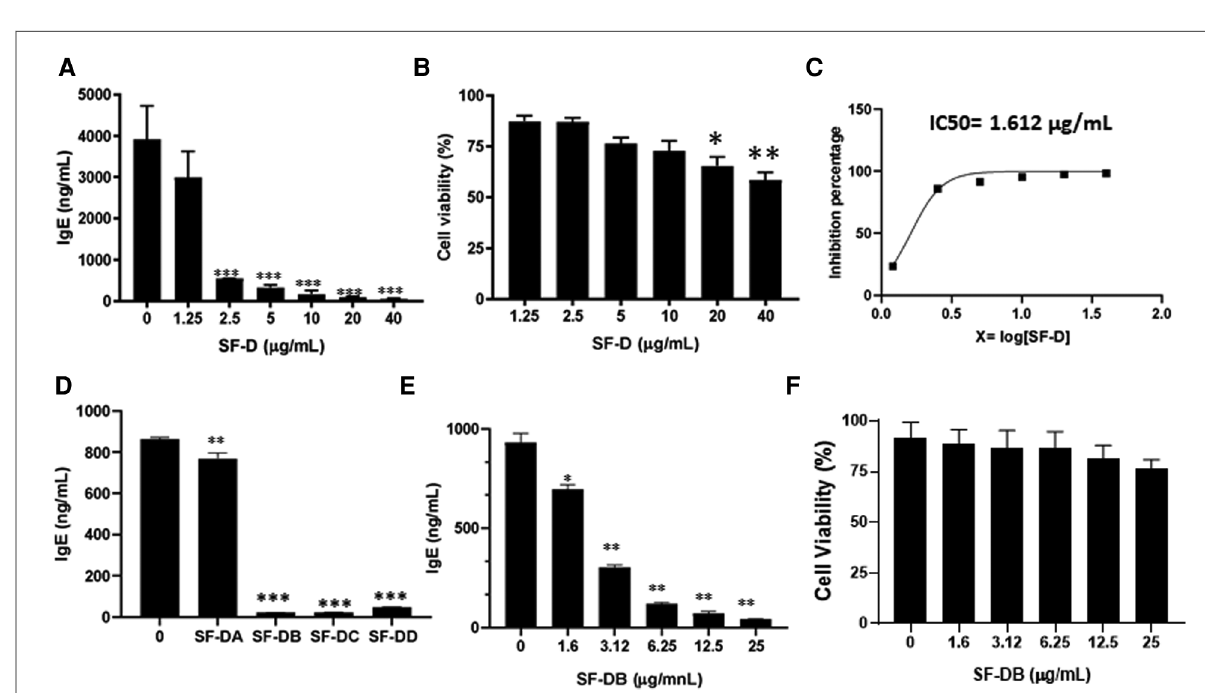
FIGURE 3 Different fractions of Sophora fl avescens on IgE production in U266 cells. ( A ) Inhibitory effect of SF-D fractions on IgE production by U266 cells. ( B ) Cell viability of cultured U266 cells with SF-D fractions. ( C ) Percentage of IgE inhibition vs. log [SF-D concentration] curve. ( D ) Inhibitory effect of SF-D-sub-fractions, SF-DA, SF-DB, SF-DC, SF-DD on IgE production by U266 cells. ( E ) Dose-dependent experiment of SF-DB on IgE production by U266 cells. ( F ) Cell viability of cultured U266 cells with or without SF-DB.* p <0.05; ** p <0.01; *** p <0.001. Data represents triplicate